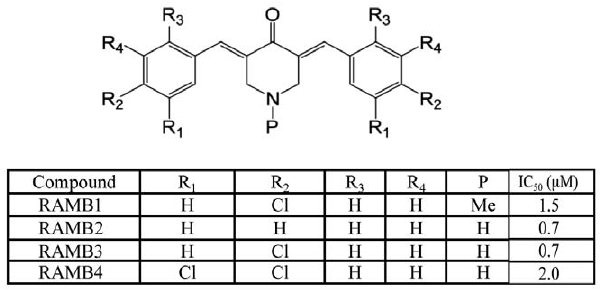
Figure 1. Summary of the structure of compounds RAMB1–4 and their IC 50 values in HeLa cervical cancer cell line. IC 50 values were determined by XXT assay. The IC 50 value reported are average of three independent